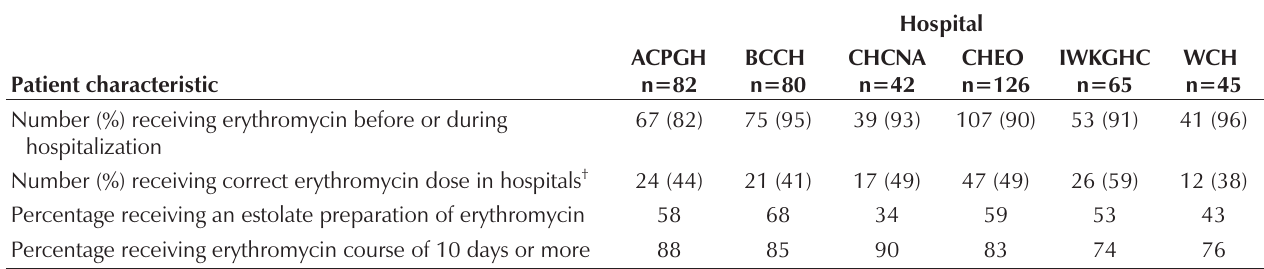
Selected nonantibiotic treatment given to 440 children admitted to six tertiary care hospitals with a primary admission diagnosis of pertussis Patient characteristic Number (%) receiving inhaled salbutamol (excluding children with reactive airways disease) Number (%) receiving oral intravenous or inhaled steroids (excluding children with reactive airways